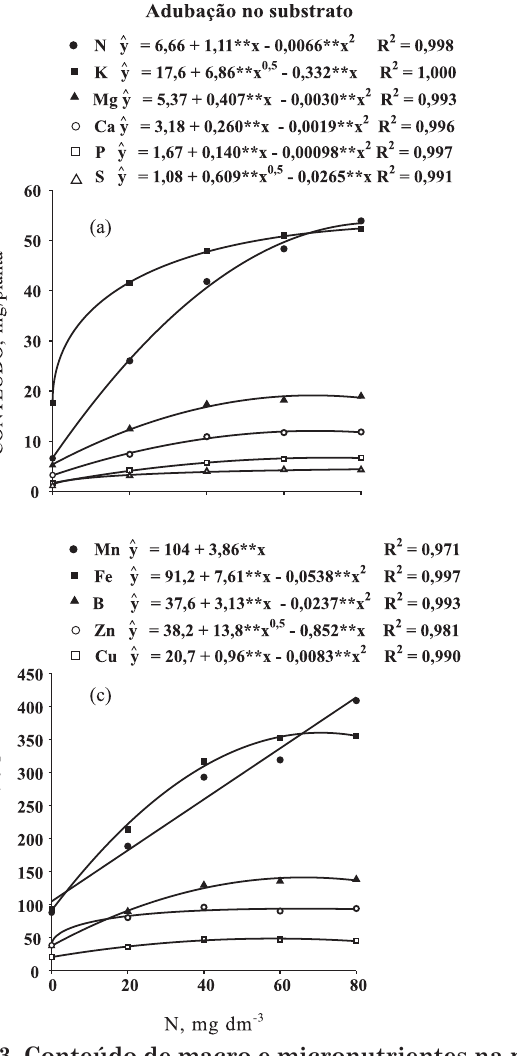
Figura 3. Conteúdo de macro e micronutrientes na parte aérea de mudas de cacaueiro, aos 145 dias, em função da dose de nitrogênio e forma de adubação: no substrato ou foliar. ** e *, significativo a 1 e 5 % pelo teste F,